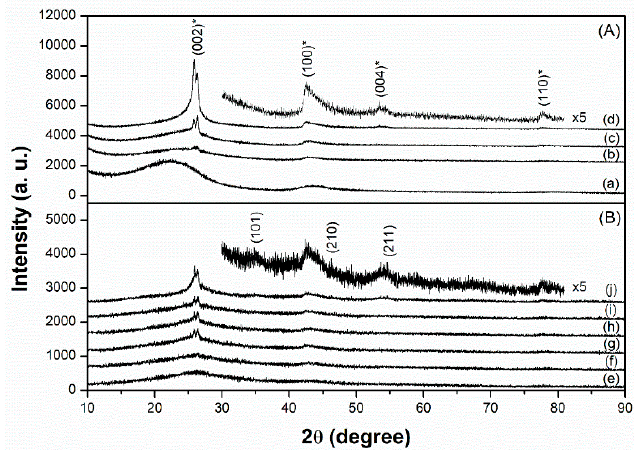
Figure 1. Wide-angle X-ray di ff raction (XRD) patterns of ( A ) carbon materials—(a) AC, Figure 1 . Wide-angle X-ray diffraction (XRD) patterns of ( A ) carbon materials – (a) AC, (b) MPC-15, (b) MPC-15, (c) MPC-18 and (d) MPC-21 and ( B ) the prepared Cs-Ru catalysts—(e) 2.5Cs-10Ru / AC, (c) MPC-18 and (d) MPC-21 and ( B ) the prepared Cs-Ru catalysts – (e) 2.5Cs-10Ru/AC, (f) 2.5Cs- (f) 2.5Cs-10Ru / MPC-15, (g) 10Cs-2.5Ru / MPC-18, (h) 5Cs-5Ru / MPC-18, (i) 2.5Cs-10Ru / MPC-18 and (j) 2.5Cs-10Ru / MPC-21. The “asterisk” peaks are associated with the carbon materials. The peaks of samples (d) and (j) are enlarged and inserted in Figure 1A,B,